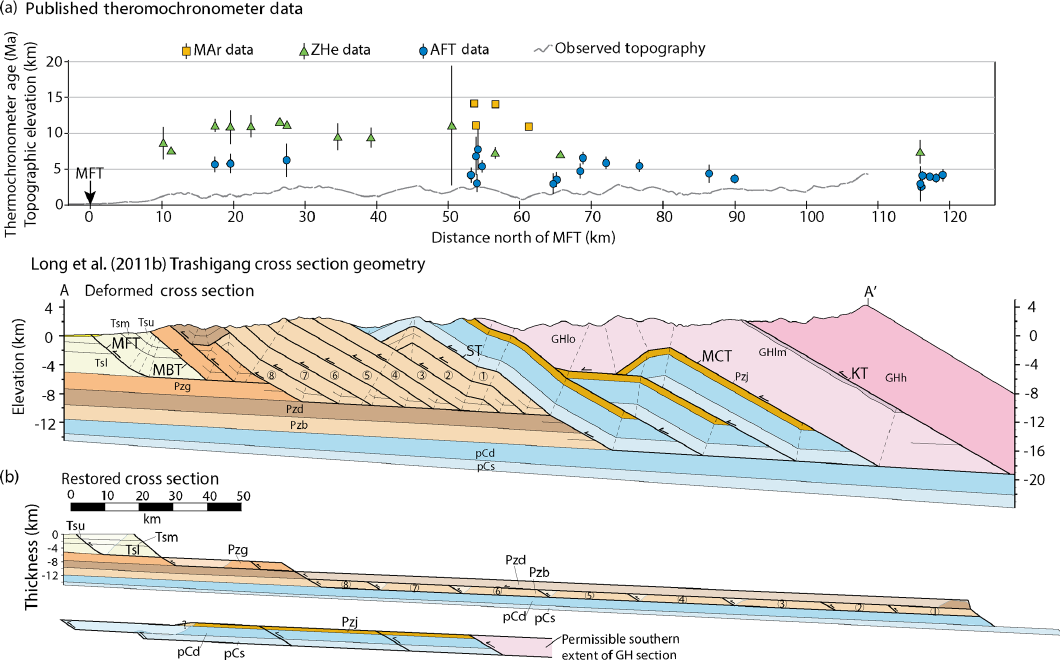
Figure 2. (a) Published MAr (yellow), ZHe (green), and AFT (blue) thermochronometer data plotted in the direction of transport along the Trashigang section. Topographic profile along the line of section is also shown. (b) Simplified balanced geologic cross section of the Trashigang region of Bhutan modified from Long et al. (2011b). Scale of the deformed section is represented on the above graph. All unit and fault abbreviations are the same as in Fig.